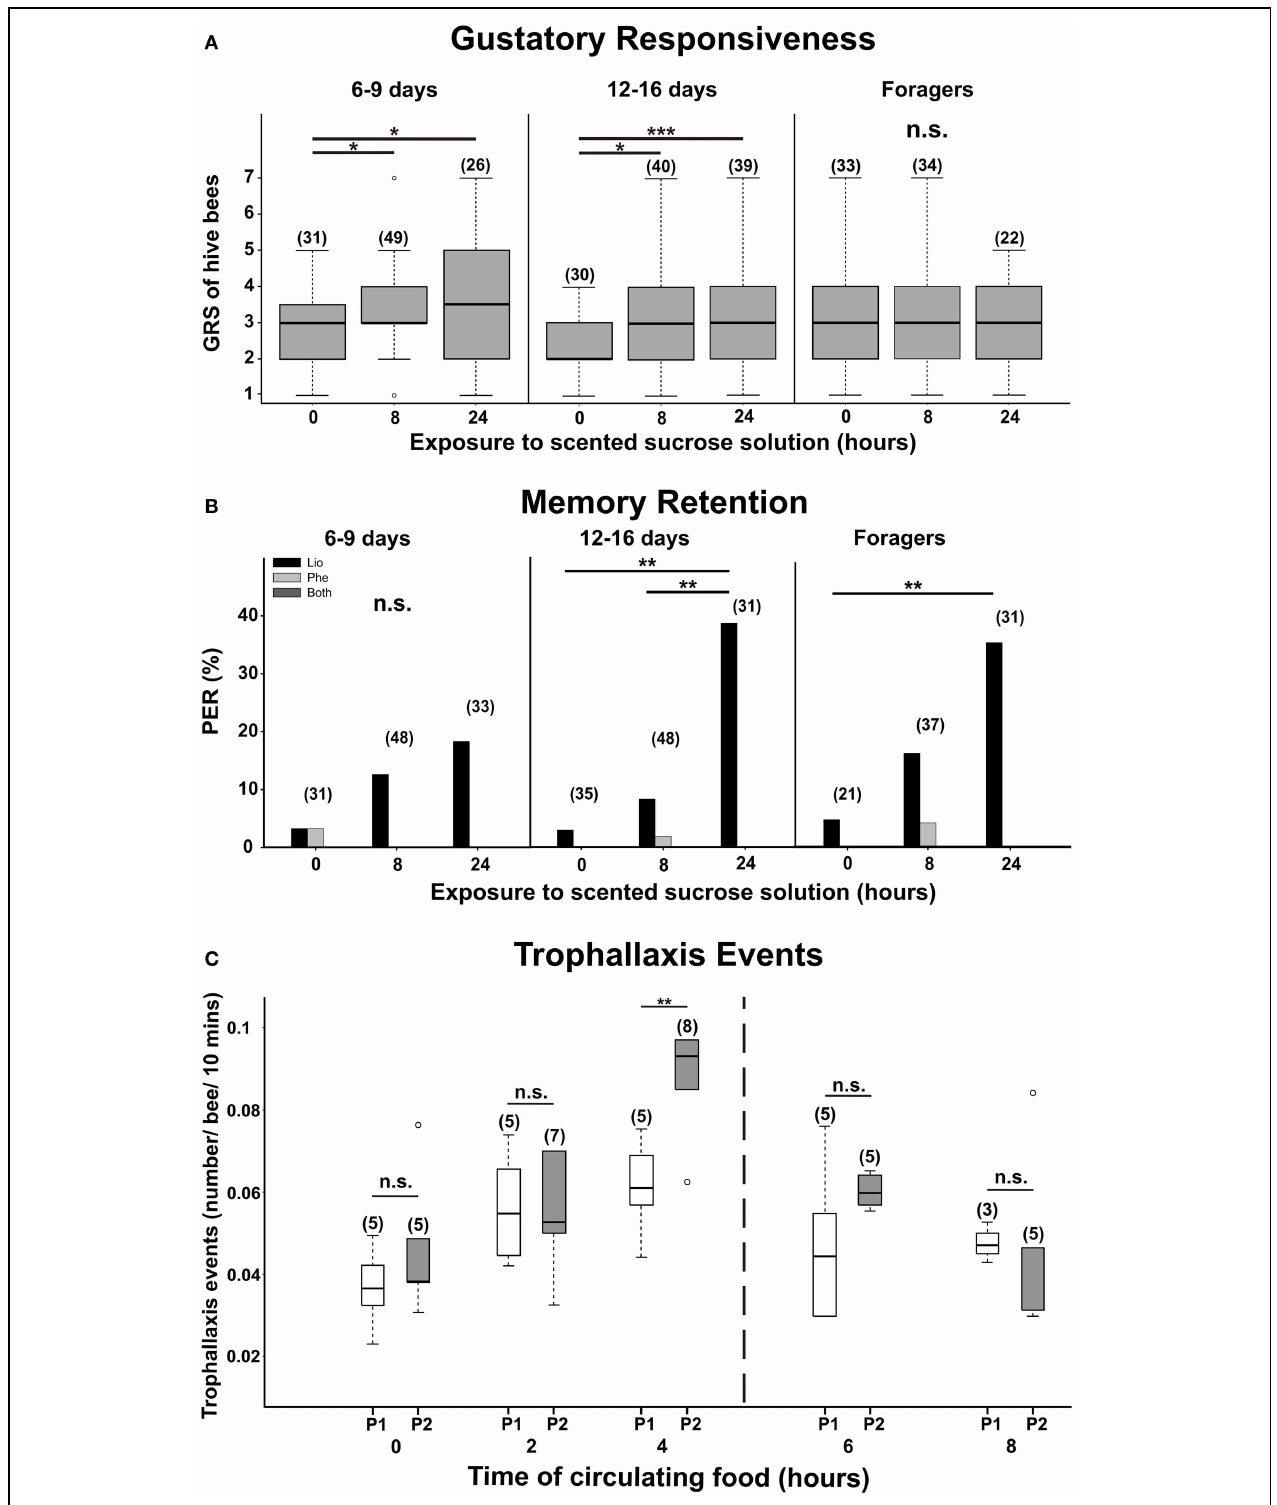
FIGURE 1 | Gustatory responsiveness and memory retention of free-flying bees after the influx of scented sucrose solution. Bees of different age groups: 6/9 days old, 12/16 days old, and foragers were captured from the hive. Gustatory response scores (GRSs) (A) and proboscis